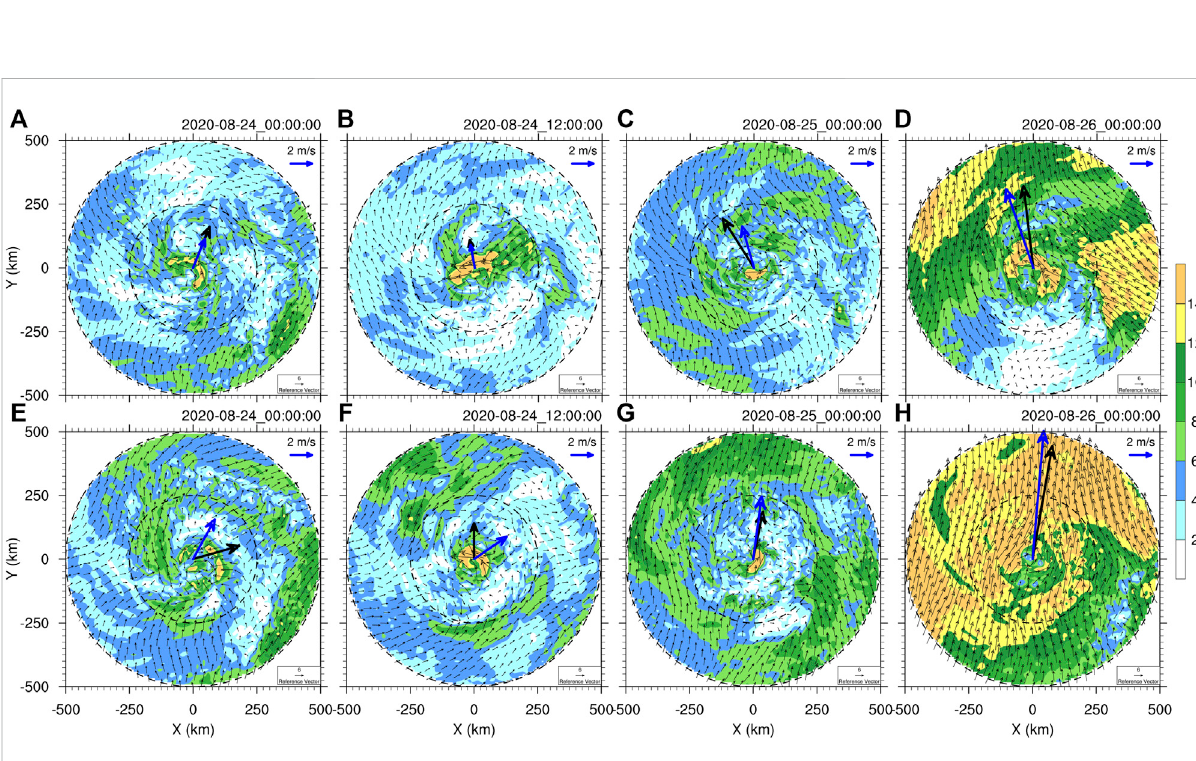
FIGURE 5 Simulated500-hPaasymmetricwinds(vectors,m s − 1 )andspeedsgreaterthan2 m s − 1 (shaded)inthe9-kmdomaininbothCTRL(upperpanels) and No-trough (lower panels). Black and blue thick arrows indicate the TC motion vector and the averaged asymmetric wind vector within 500 km from the TC center. Black dotted circles are 250 and 500 km away from the TC